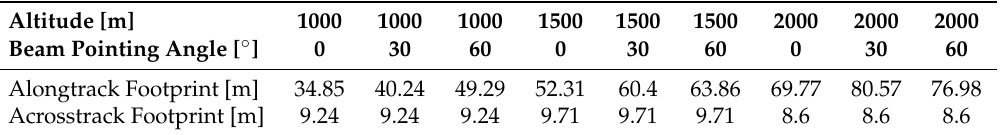
Table 18. Along and across track resolutions for EM 304 2x4, 1000/1500/2000 m, and swath limited to 2